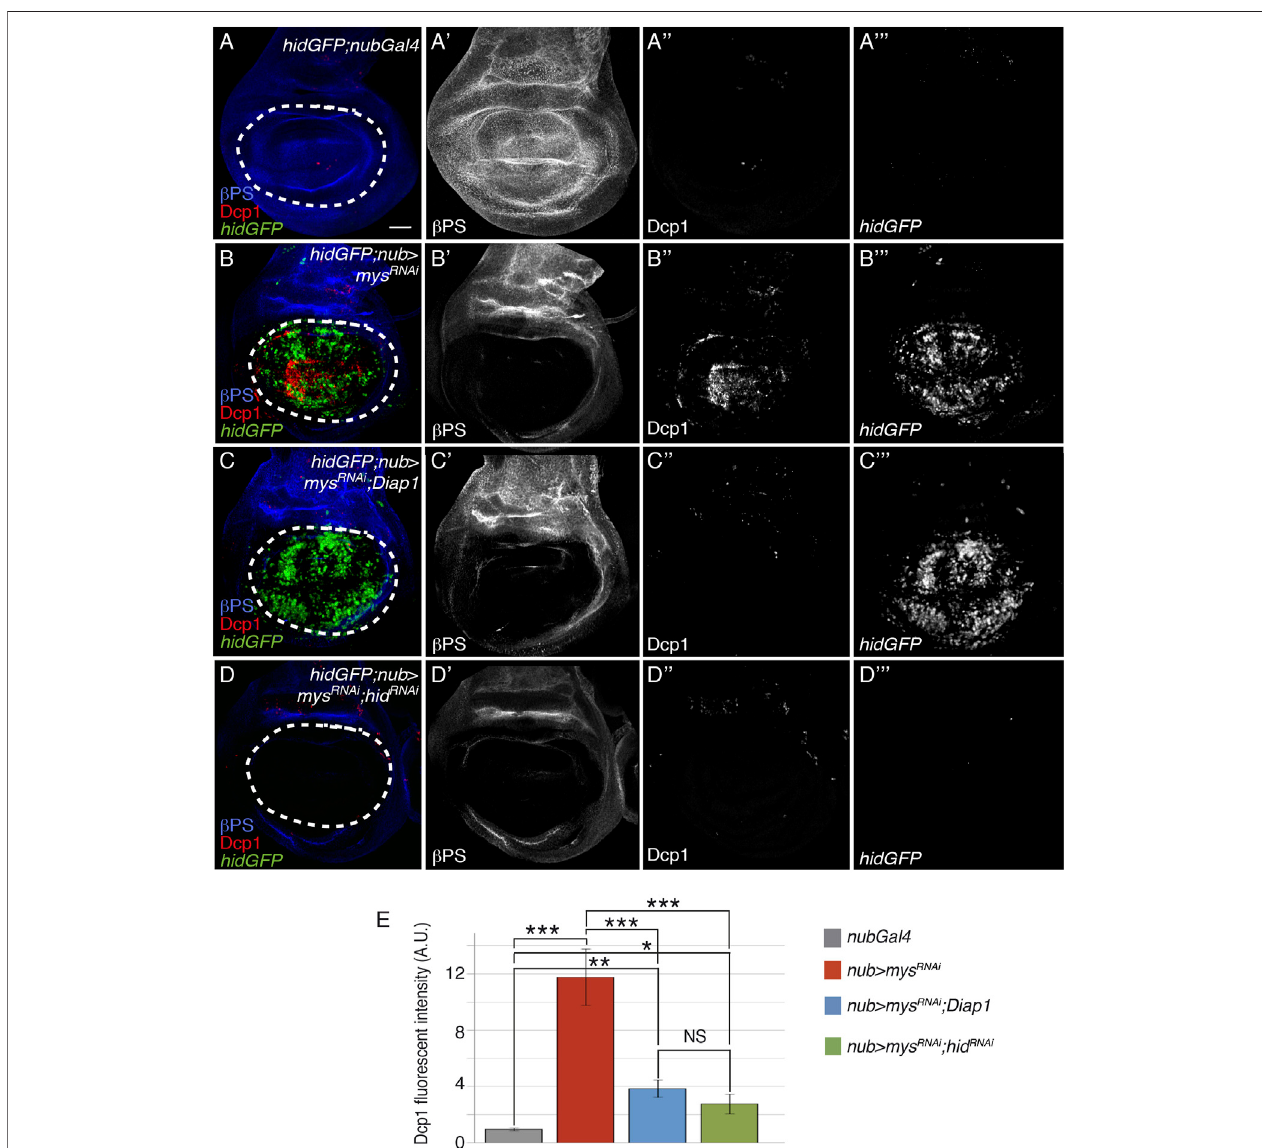
FIGURE 2 | Integrins stimulate cell survival through inhibition of hid expression. (A – D - ) Maximal projection of confocal views of third-instar wing imaginal discs stained with anti- β PS [blue in (A – D) , white in (A 9 – D 9 )] , anti-Dcp1 [red in (A – D) , white in (A 99 – D 99 )] and anti-GFP [green in (A – D) , white in (A - – D - )] . (A – A - ) Control nubGal4 wing disc carrying a reporter of hid expression, hidGFP , hidGFP; nubGal4 . (B – B - ) hidGFP wing disc expressing a mys RNAi under the control of nubGal4 , hidGFP;nub > mys RNAi . (C – D - ) hidGFP wingdiscco-expressinga mys RNAiunderthecontrolof nubGal4 witheitherDiap1, hidGFP;nub > mys RNAi ; Diap1 (C – C - ) , ora hid RNAi, hidGFP;nub > mys RNAi ; hid RNAi (D – D - ) . (E) Quanti fi cationofDcp1 levelsinwingdiscsoftheindicatedgenotypes.Thestatisticalsigni fi cance ofdifferences was assessed with a t -test, ***, ** and * p values < 0.001, < 0.01, and < 0.05, respectively. NS, non-statistically signi fi cant. Scale bar in all panels, 30 μ m.